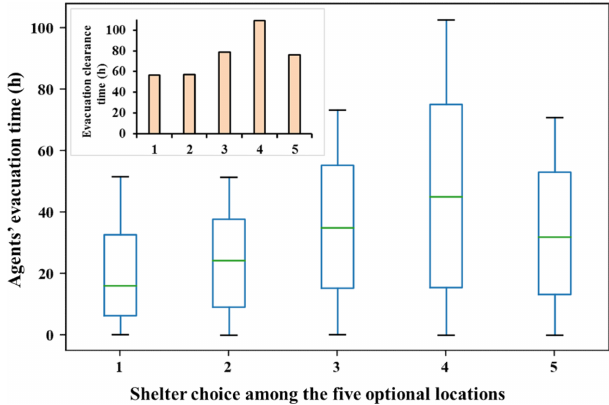
Figure 8. Box plot of agents’ evacuation times (main figure) and the system-level evacuation clearance times for the five one-shelter scenarios